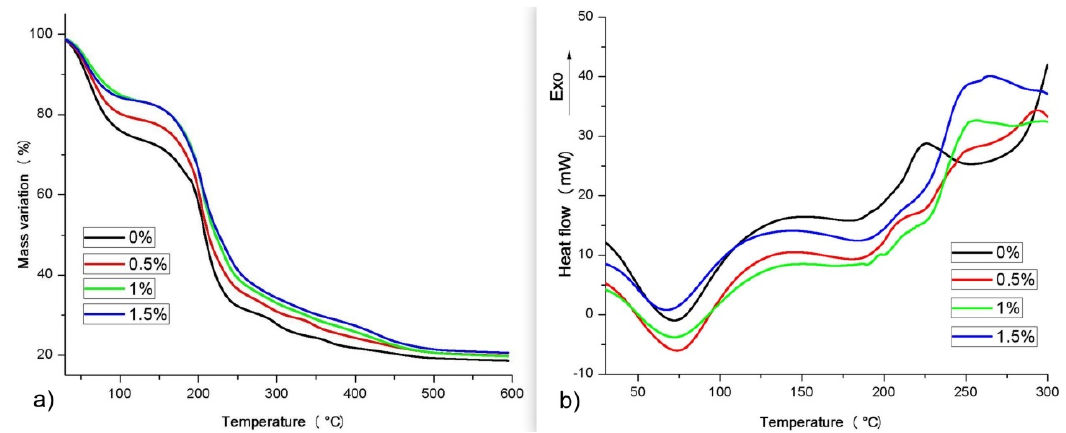
Figure 1. ( a ) Thermogravimetric (TG) and ( b ) differential scanning calorimetry (DSC) curves of the bioactive films obtained from the incorporation of cashew nut shell liquid into a sodium alginate matrix.